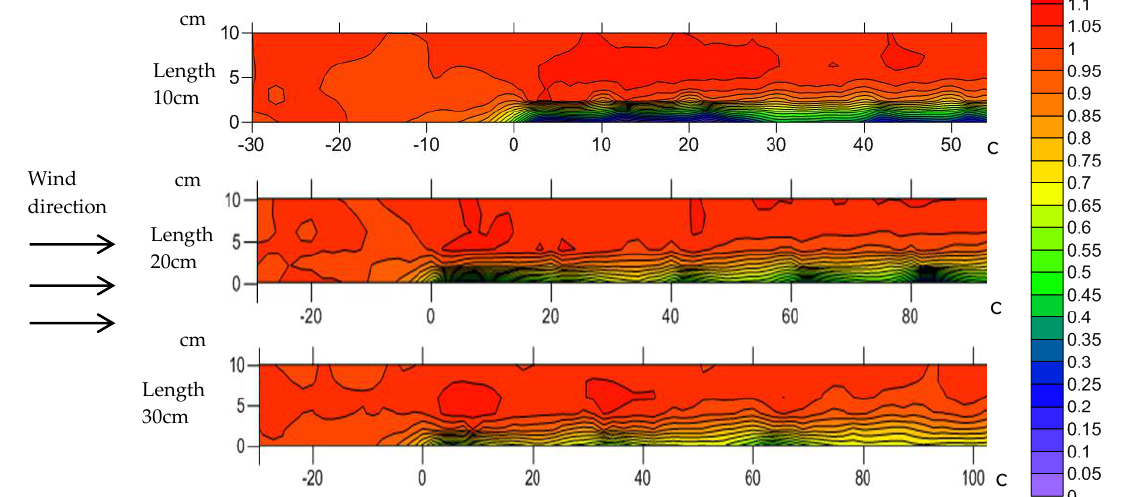
Figure 4. Longitudinal section of the rate of wind speed acceleration of straw checkerboard.